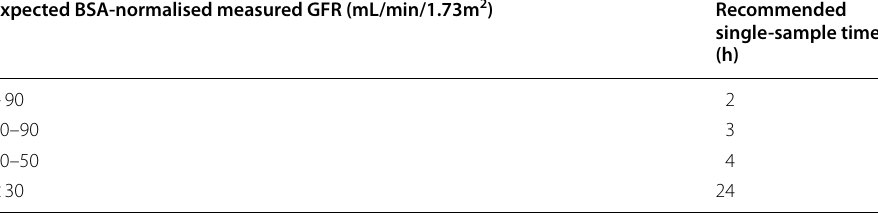
Table 4 Proposed recommended single-sample times to use with the Fleming formula based on expected BSA-normalised GFR Expected BSA-normalised measured GFR (mL/min/1.73m 2 ) Recommended